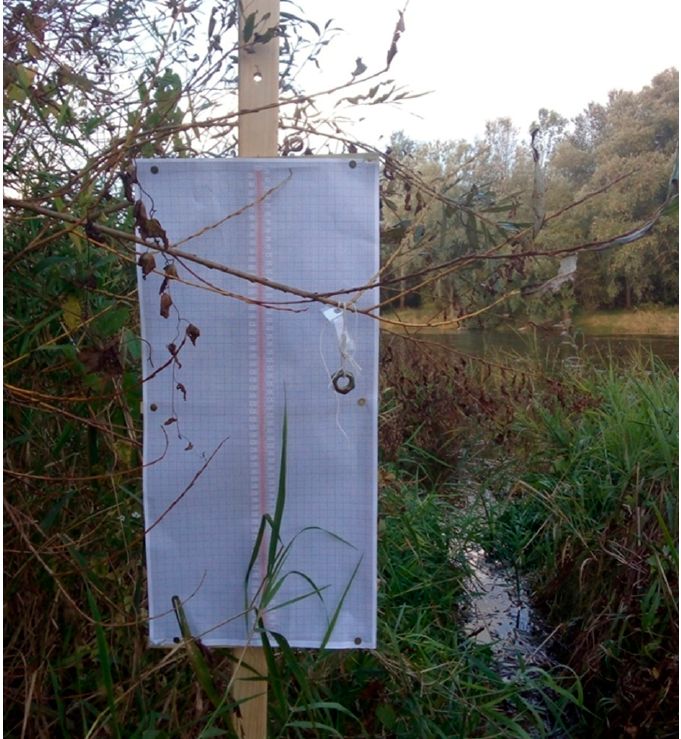
Figure 7. Branch on shrub No. 3 during measurement of deflection arrow.